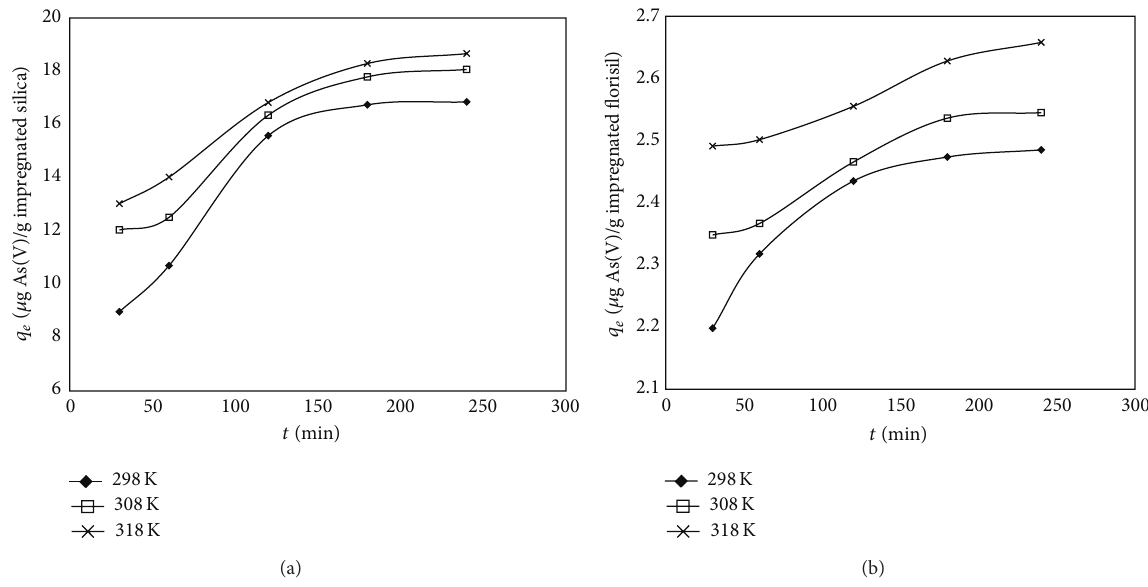
Figure 5: Influence of the contact time on the adsorption capacity of the impregnated silica (a) and on the impregnated florisil (b). 00.511.522.5